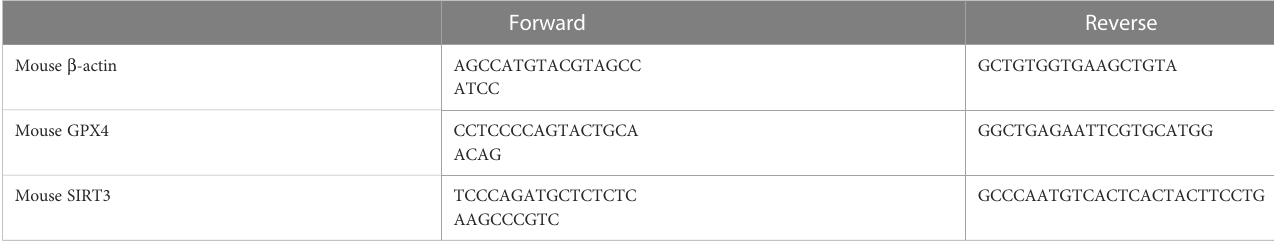
TABLE 2 Sequences of primers.